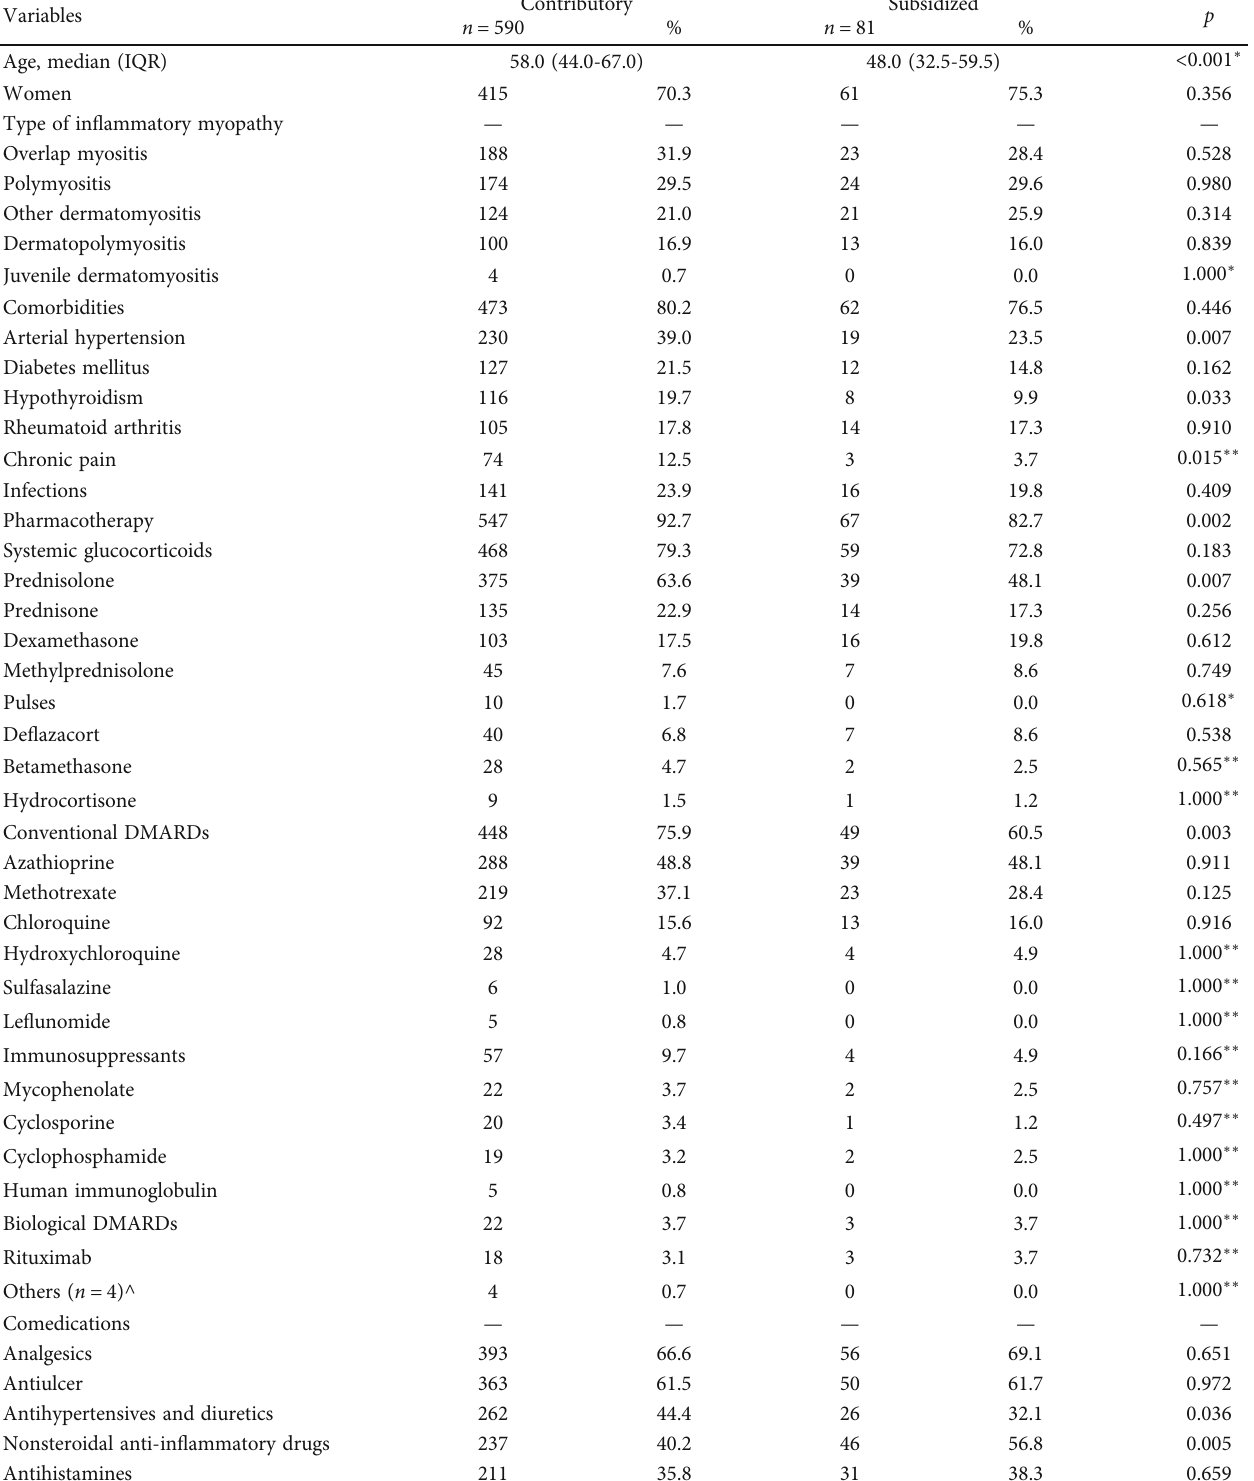
Table 5: Comparison of some sociodemographic and pharmacological variables between the types of a ffi liation regimen to the health system of patients diagnosed with autoimmune idiopathic in fl ammatory myopathies in